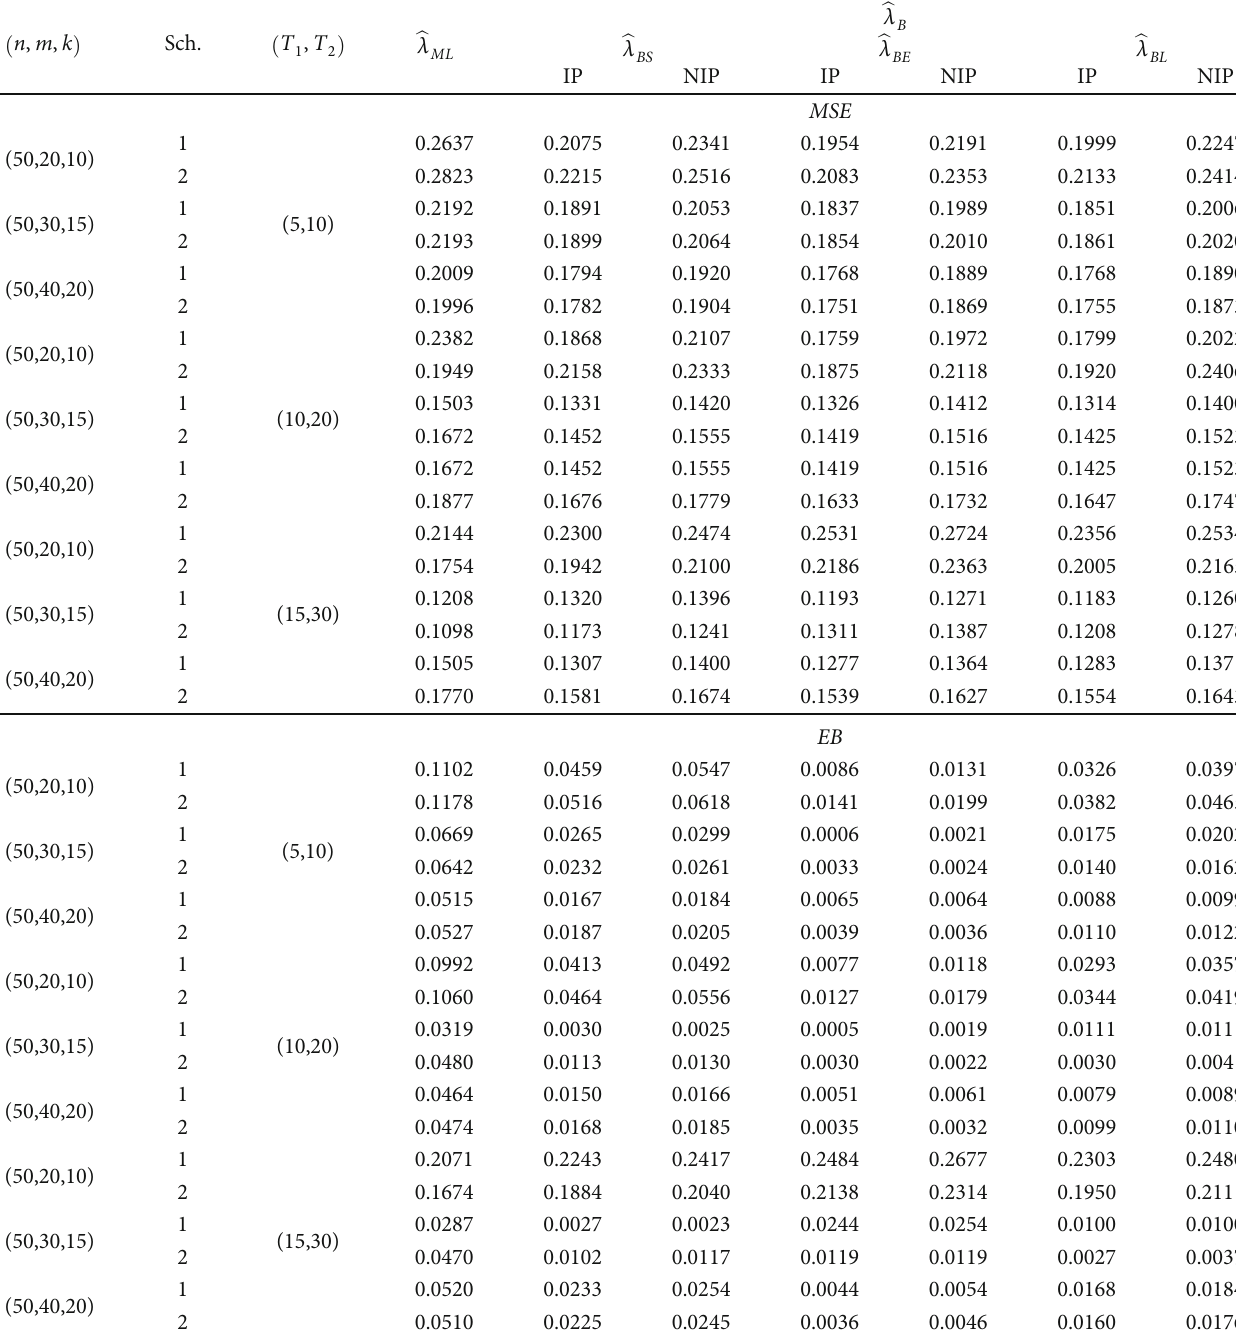
Table 1: The values of MSE and EB of ML and Bayesian estimates for λ based on the di ff erent Type-II uni fi ed PHCSs. n , m , k